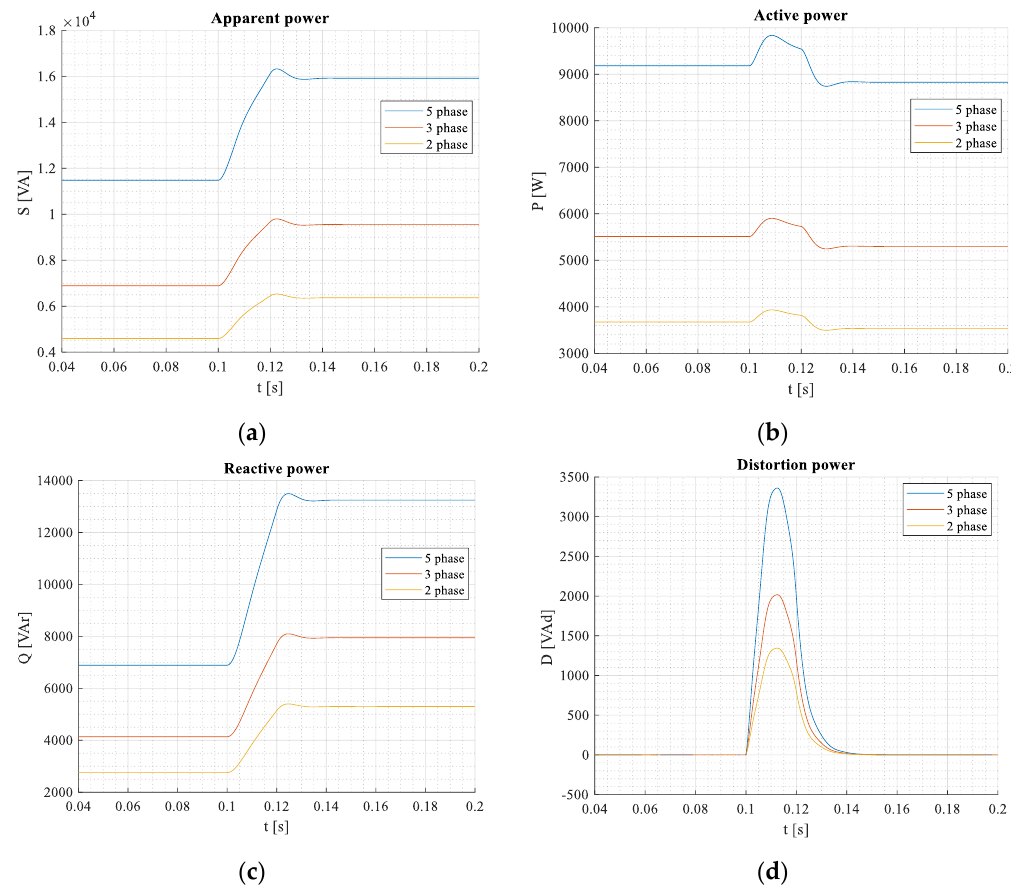
Figure 11. Apparent ( a ), active ( b ), blind ( c ), and distortion ( d ) power components during transient states for 3-, 5-, and 2-phase systems under mains supplied linear RL load. The simulation was performed under the same load phase parameters; therefore, the magnitudes are proportionately different.